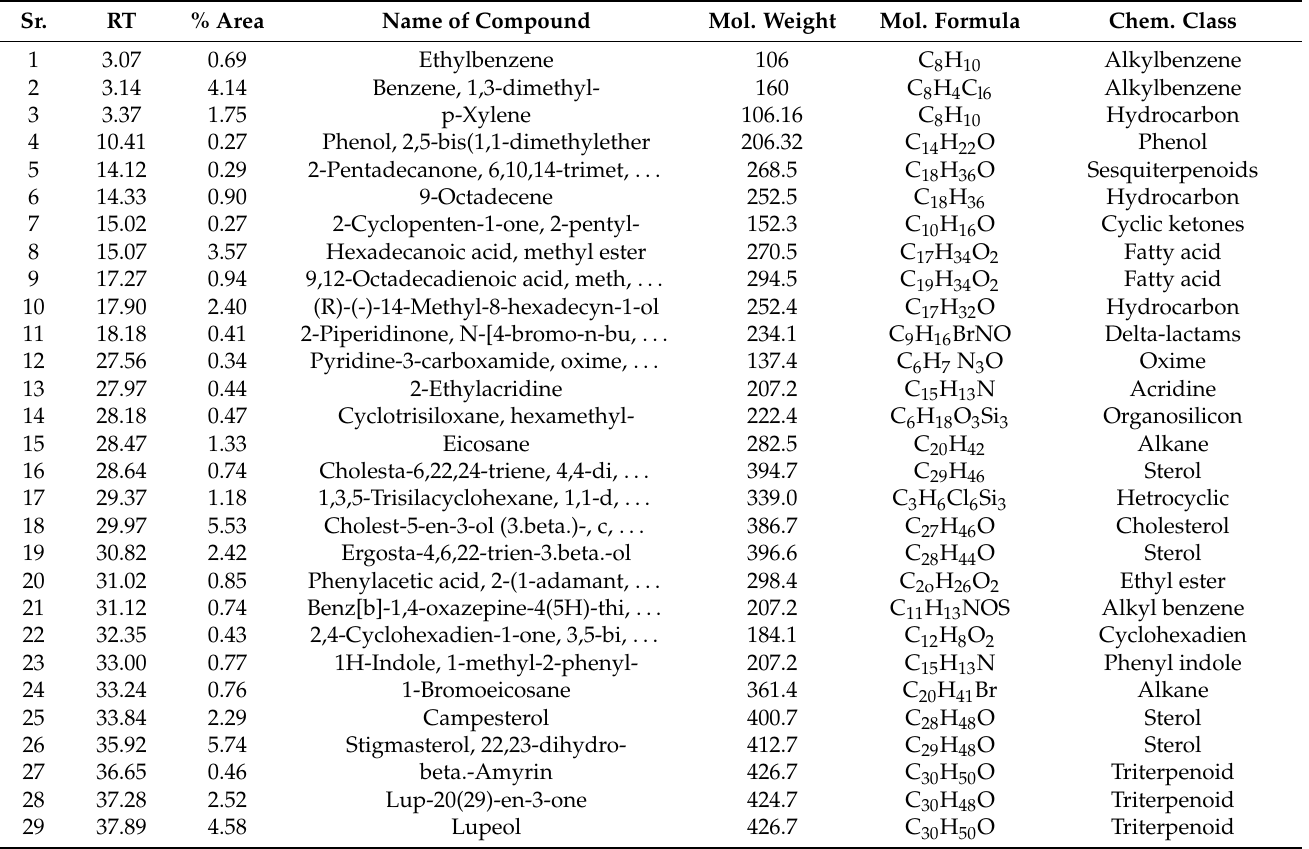
Table 1. GC-MS analysis of chloroform fraction of S. glutinosus .